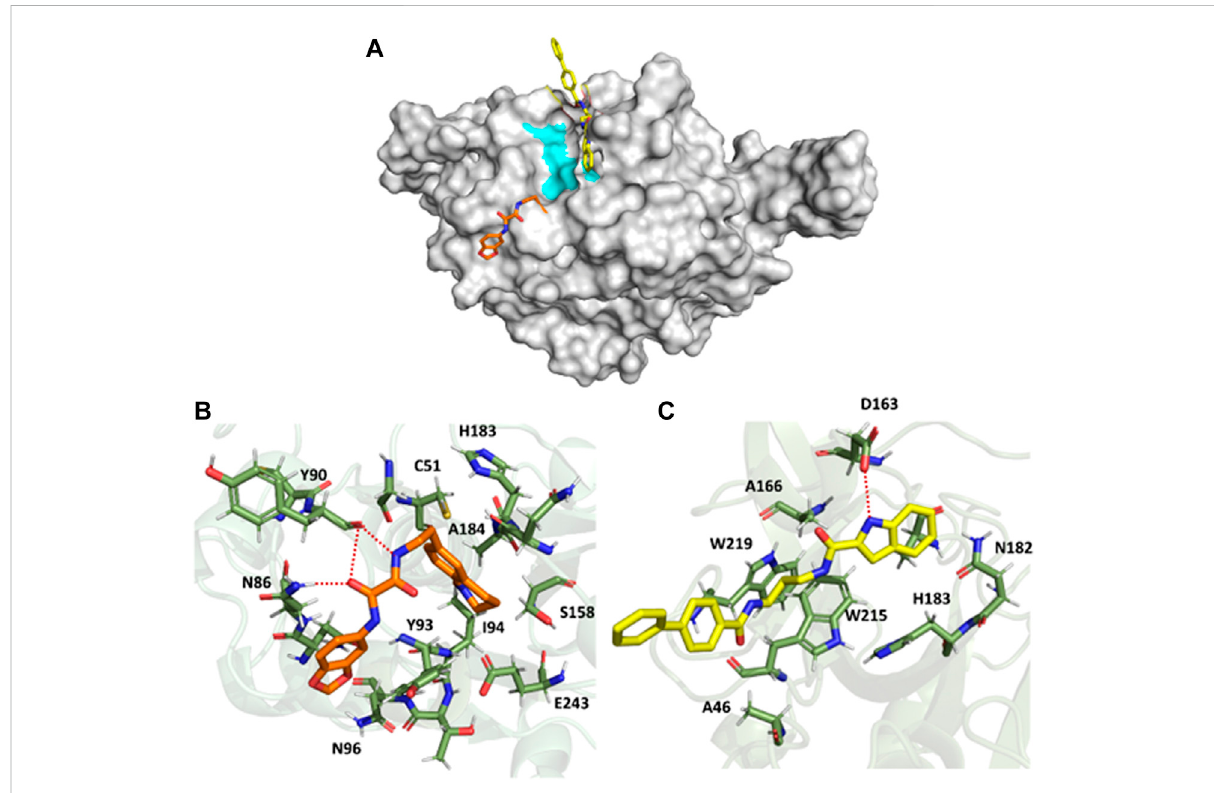
SurfacerepresentationofQOD(orange)andICD (yellow)boundneartheactive siteofFP-3(gray). Thecriticalcatalyticresidues arehighlighted in cyan (A) . FP-3 residues (green) interacting with QOD (B) and ICD (C) . Hydrogen bonds are represented by red dotted lines.